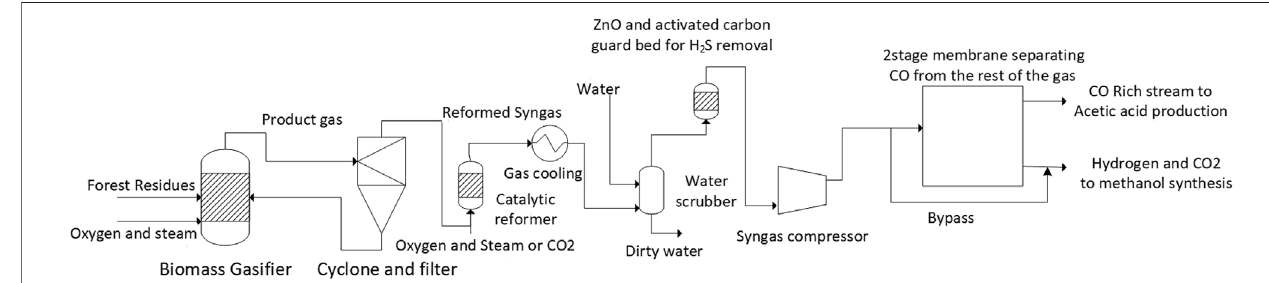
FIGURE 2 | Flowsheet of the gasi fi cation and reforming